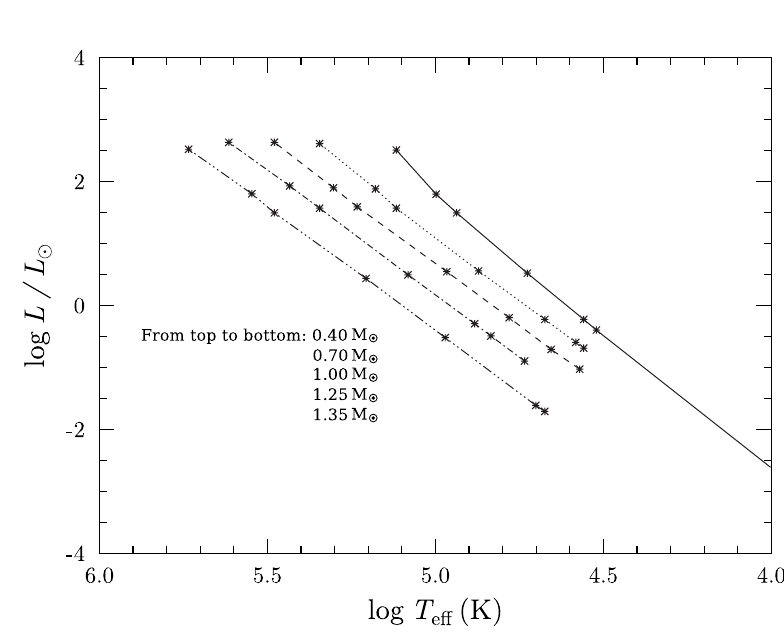
Fig. 5. We show the luminosity and effective temperature in the HR diagram for our simulations around the time just before the final thermonuclear runaway. The mass accretion rate, for all masses, increases from low effective temperatures to high effective temperatures. Most of these sequences, especially the ones occurring on the lower mass WDs would not be detected by the current low energy detectors on the X-ray